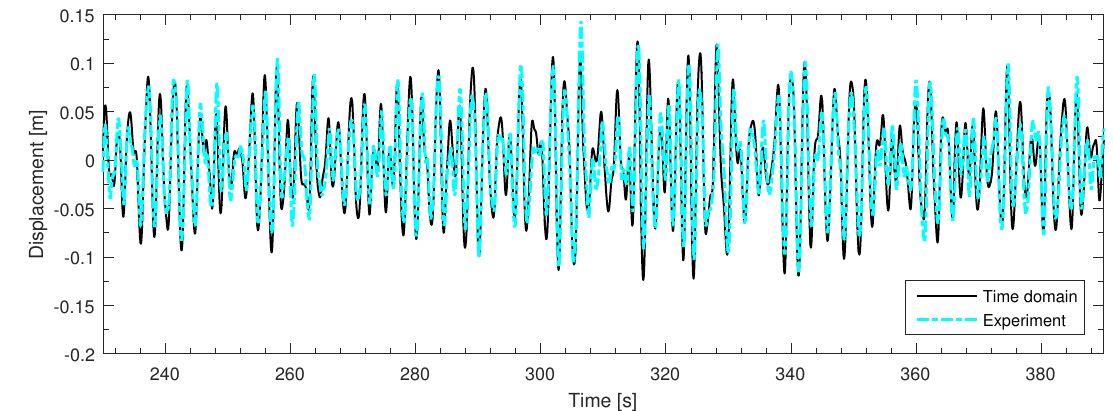
Figure 6. Heave motion response from the time domain model and the experiment.